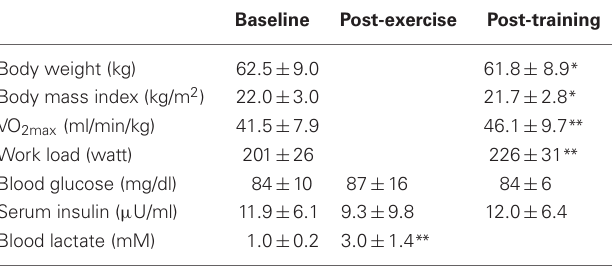
Table 1 | Subject characteristics and blood metabolic